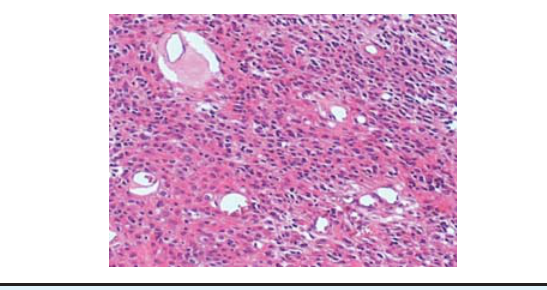
Figure 2. E. pathological specimen on H&E stain (x400) showing tumor cells with abundant cytoplasm in round to oval shape arranged in